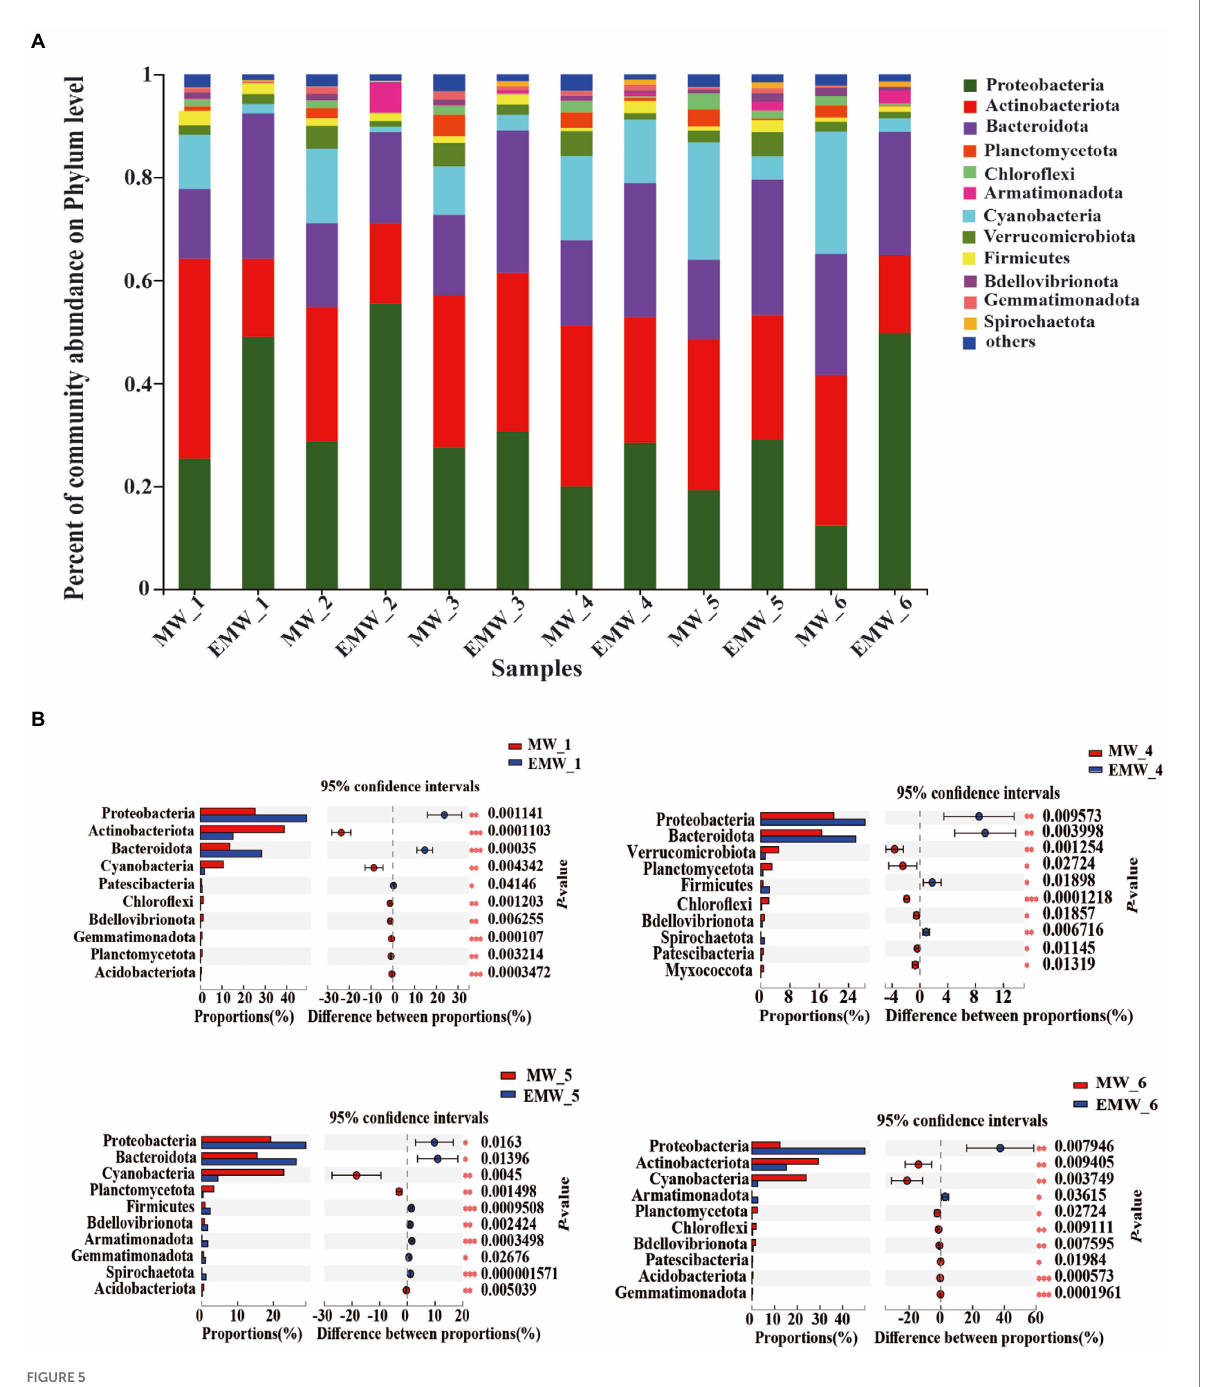
FIGURE 5 Phylum-level microbial community analysis. (A) Percent of community abundance. (B) Wilcoxon tests followed by Bonferroni corrections were performed between the two groups on days 0, 30, 60, and 90. Only the 10 most abundant phyla with significant differences are shown; * p < 0.05; ** p < 0.01; *** p <